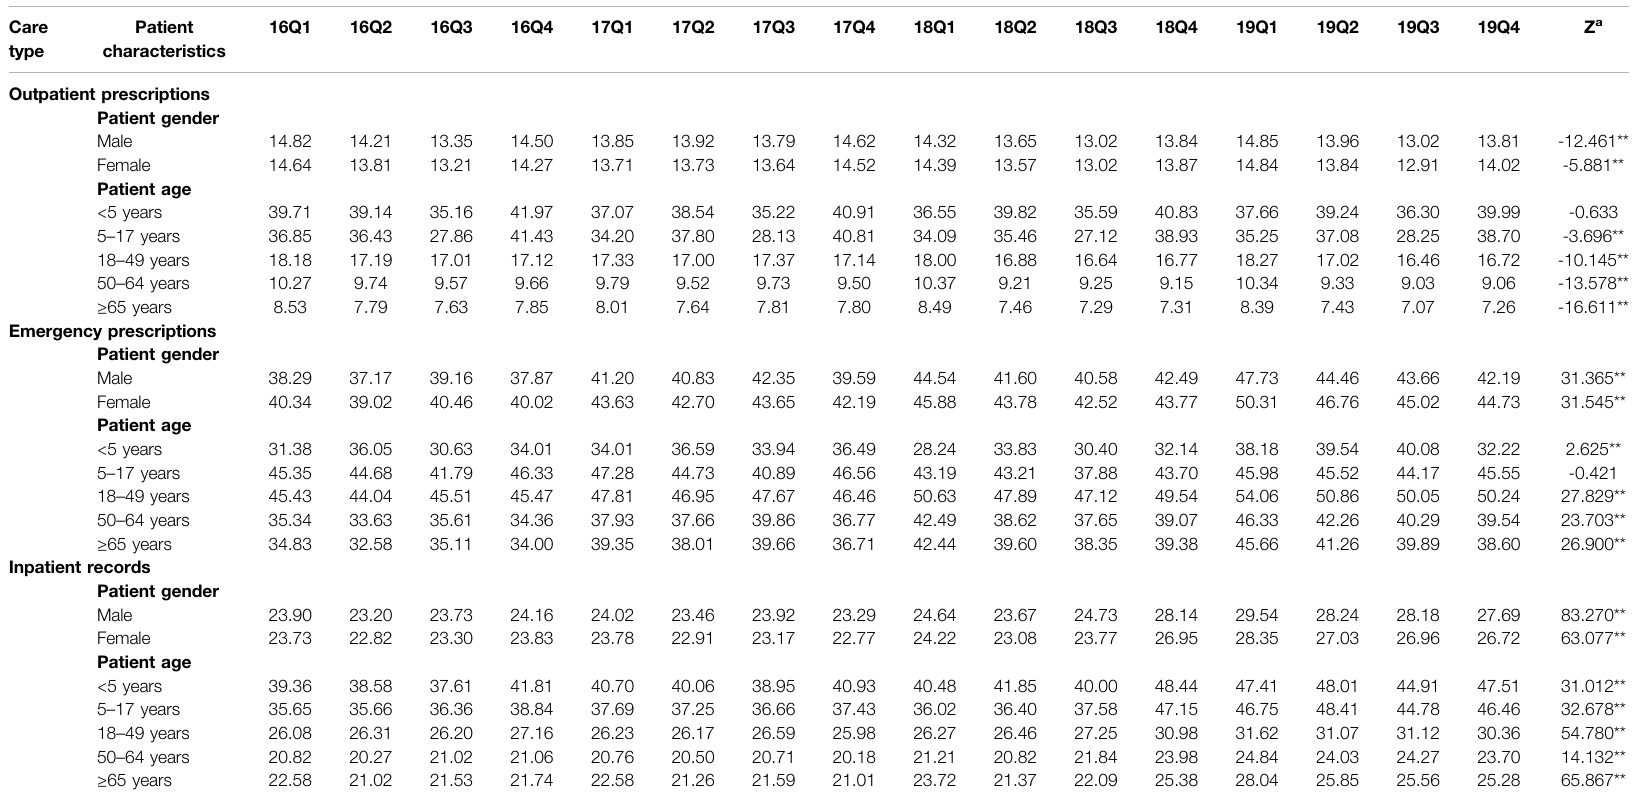
TABLE 5 | Changes in proportion of treated with antibiotics by patient characteristics, 2016 – 19. Care